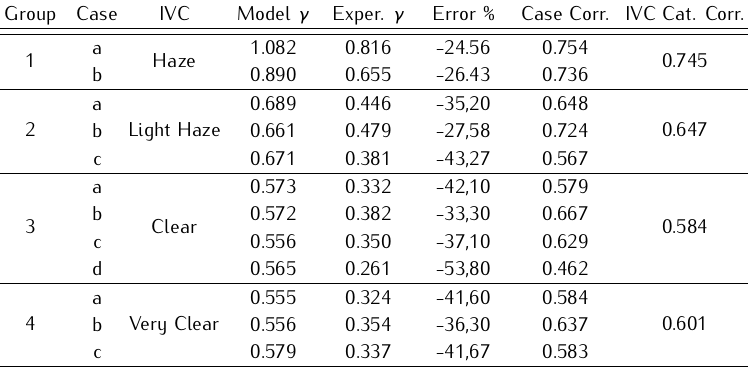
Table 19. Dry-air experimental data and ESLM model corrections ( λ = 1550 nm).